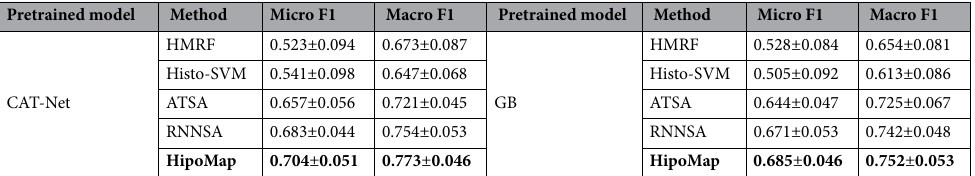
Table 4. Slide-based micro- and macro-F1 score of HipoMaps with various subtypes of lung cancer with the pretrained models of CAT-Net (left) and GB (right). The highest micro- and macro-F1 scores are highlighted in